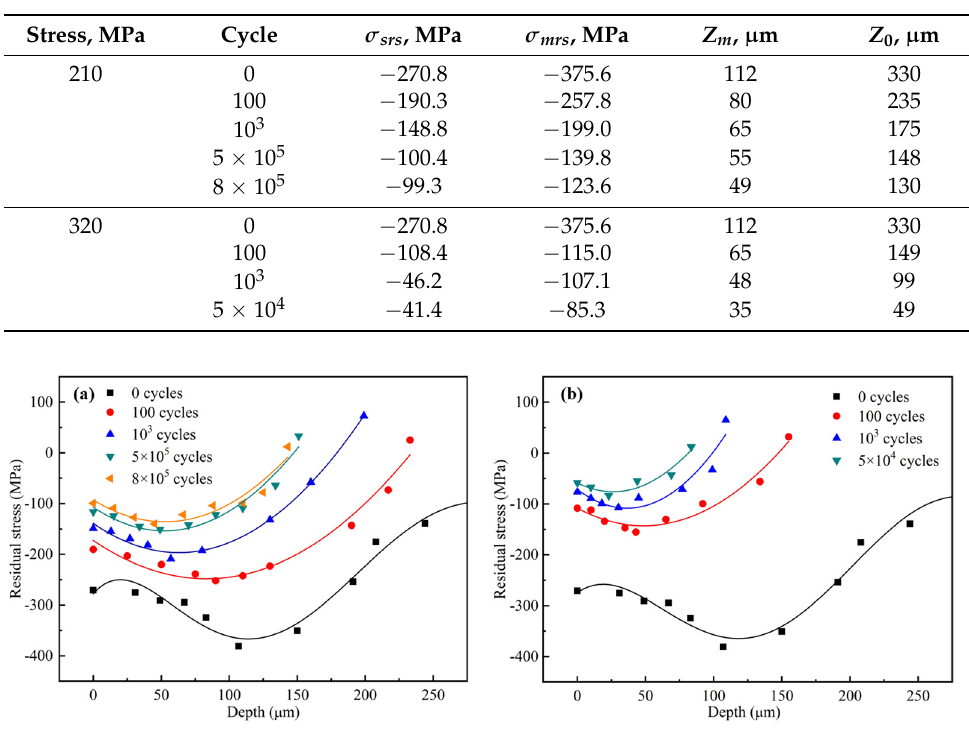
Figure 9. RSF distribution of HESPed sample under different cycles and different stress amplitudes in tensile fatigue tests: ( a ) 210 MPa; ( b ) 320 MPa.